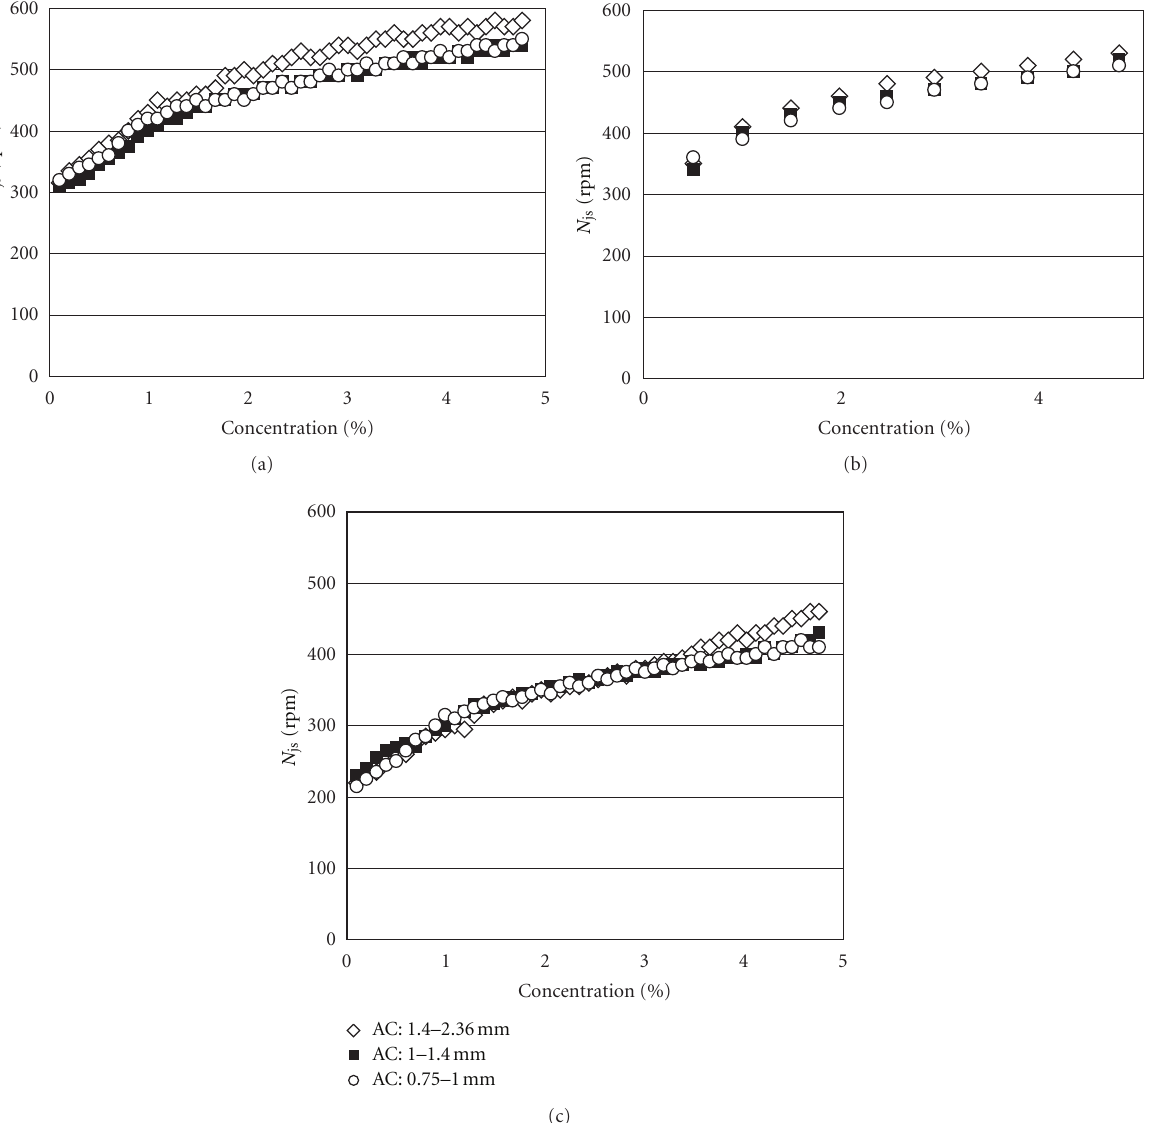
Figure 12: Graph N js (rpm) versus concentration (%), at varying sizes of activated carbon. (a) 6CB impeller, (b) 6DT impeller, and (c) 6MFD